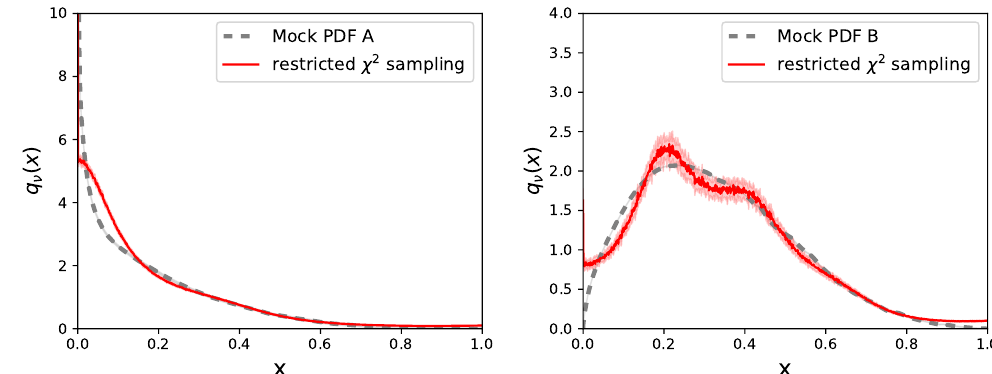
Figure 19 . Reconstructed PDF (red dashed) from restricted sampling of the (cid:31) 2 functional based on N (cid:23) = 12 Io(cid:11)e-time data points on the interval (cid:23) = [0 ; 10]. Mock scenario A is shown on the left, scenario B on the right. While positivity alone already provides a powerful regularization, for this realistic scenario we do observe deviations from the correct result, especially for scenario B.